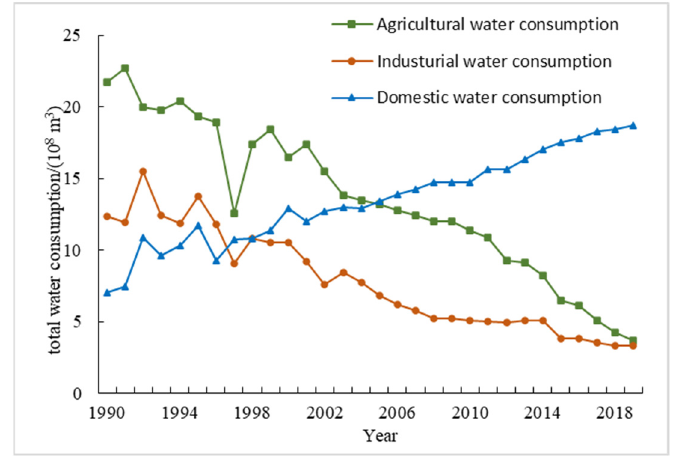
Figure 4. Water consumption in Beijing.